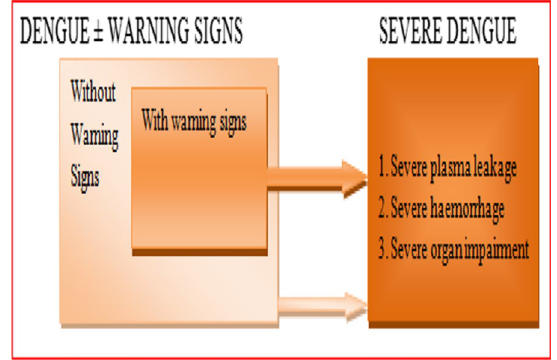
Fig. 5 Suggested dengue case classification and levels of